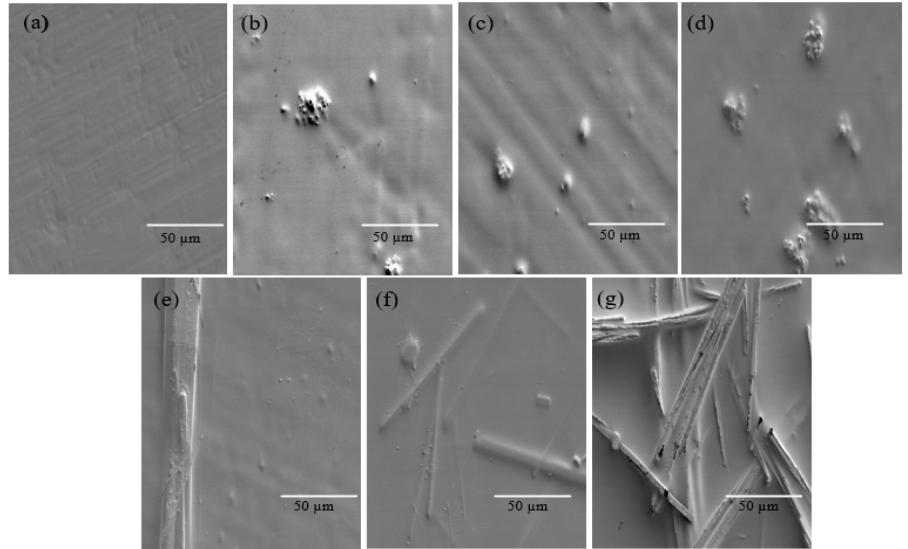
Figure 1. SEM micrographs of the composite film surface ( a ) PLA/PBAT ( b ) PLA/PBAT-TA1%, ( c ) PLA/PBAT-TA5%, ( d ) PLA/PBAT-TA10%, ( e ) PLA/PBAT-GA1%, ( f ) PLA/PBAT-GA5%, ( g ) PLA/PBAT-GA10%. ( g )